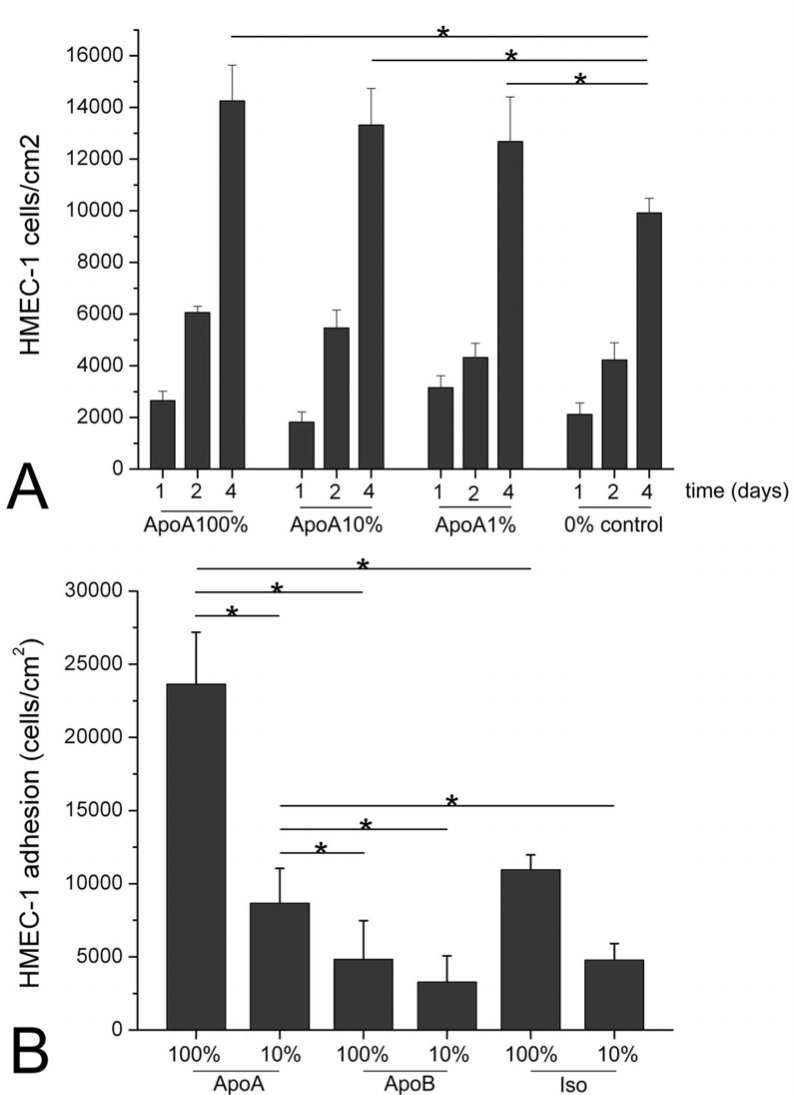
HMEC-1 cell growth on coated and uncoated disks.HMEC-1 cell growth on ApoA-I-coated discs in 100%, 10% and 1% density, incubated in HDL after 1, 2 and 4 days, compared to similarly incubated uncoated discs (control). Error bars indicate Standard Deviation (SD) of mean (n = 3). (* = P<0.05). HMEC-1 cell adhesion (B) on disks—HMEC-1 cell adhesion on ApoA-I-, ApoB- or Isotype-coated discs with 100% and 10% antibody density, incubated for 4 days. Error bars indicate Standard Deviation (SD) of mean (n = 4). (* = P<0.05)